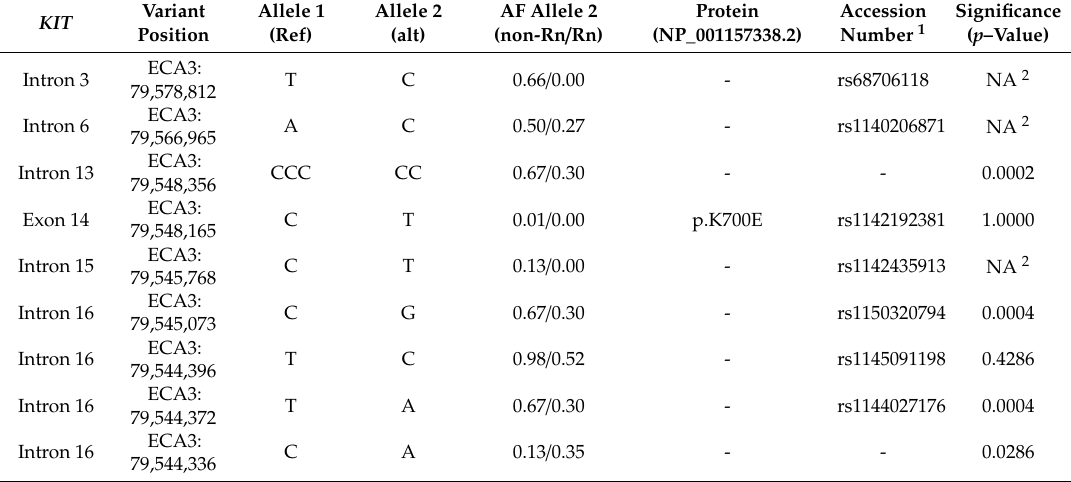
Table 2. Identified KIT variants in Icelandic horses. Positions of the variants are based on EquCab3.0. The equine genome reference sequence was considered to represent the reference allele (ref). The alternate allele (alt) and the allele frequency (AF) of the alternate allele in non-roan (non-Rn) and roan (Rn) horses are given. Empirical p -values were derived from an association study using the options assoc and mperm implemented in